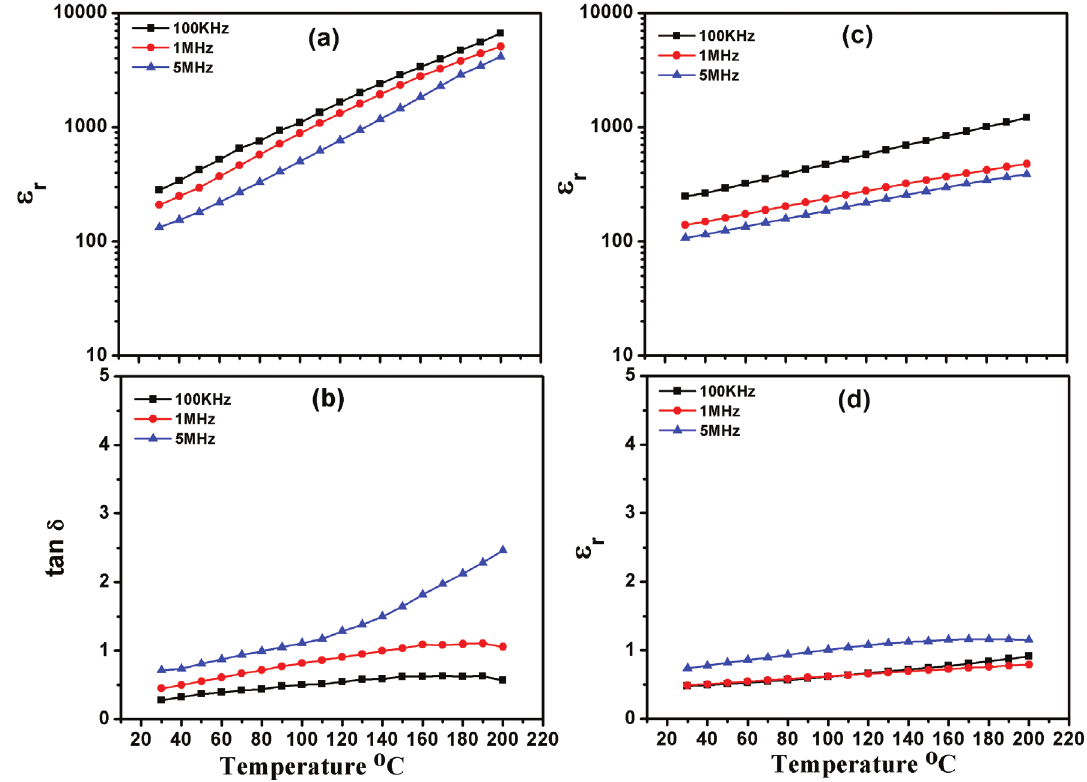
and dielectric loss tan δ for ( a ) and ( b ) SmCTO25 and ( c ) and ( d ) r